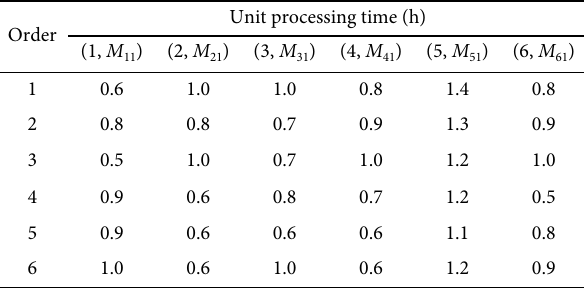
Table 5 Unit processing